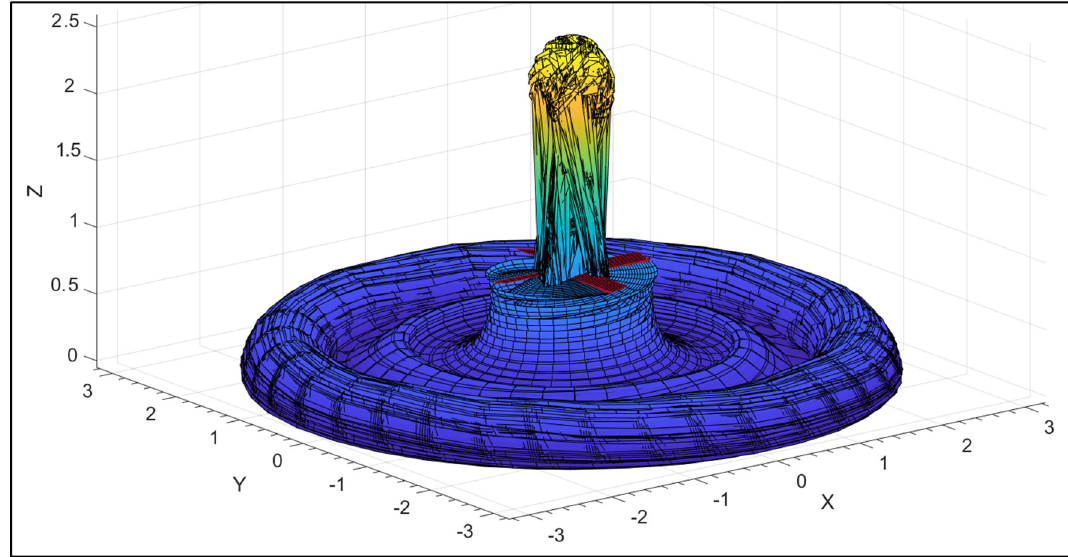
Figure 16. View of the symmetric wake produced by the four-blade rotor hovering in ground e ff ect (IGE).